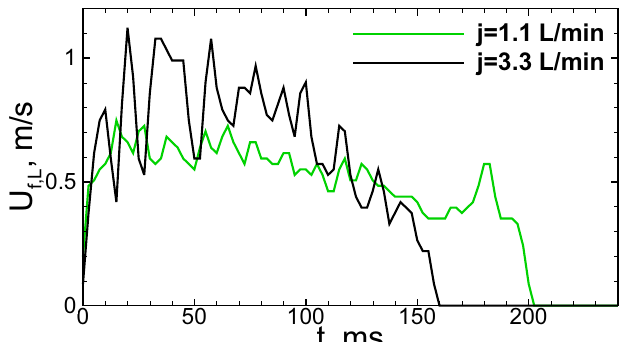
Figure 2. Experimentally obtained histories of the flame speed in a laboratory reference frame for two different flow rates.